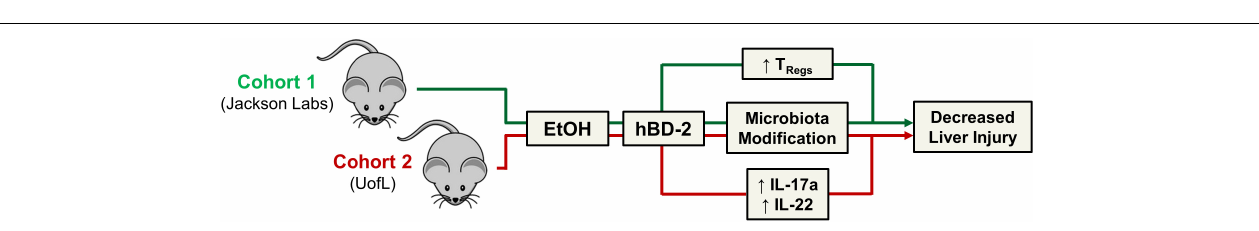
FIGURE 8 | Summary figure. Schematic representation of study findings. hBD-2 ameliorated experimental alcohol-associated liver disease in two independent cohorts of mice with distinct gut